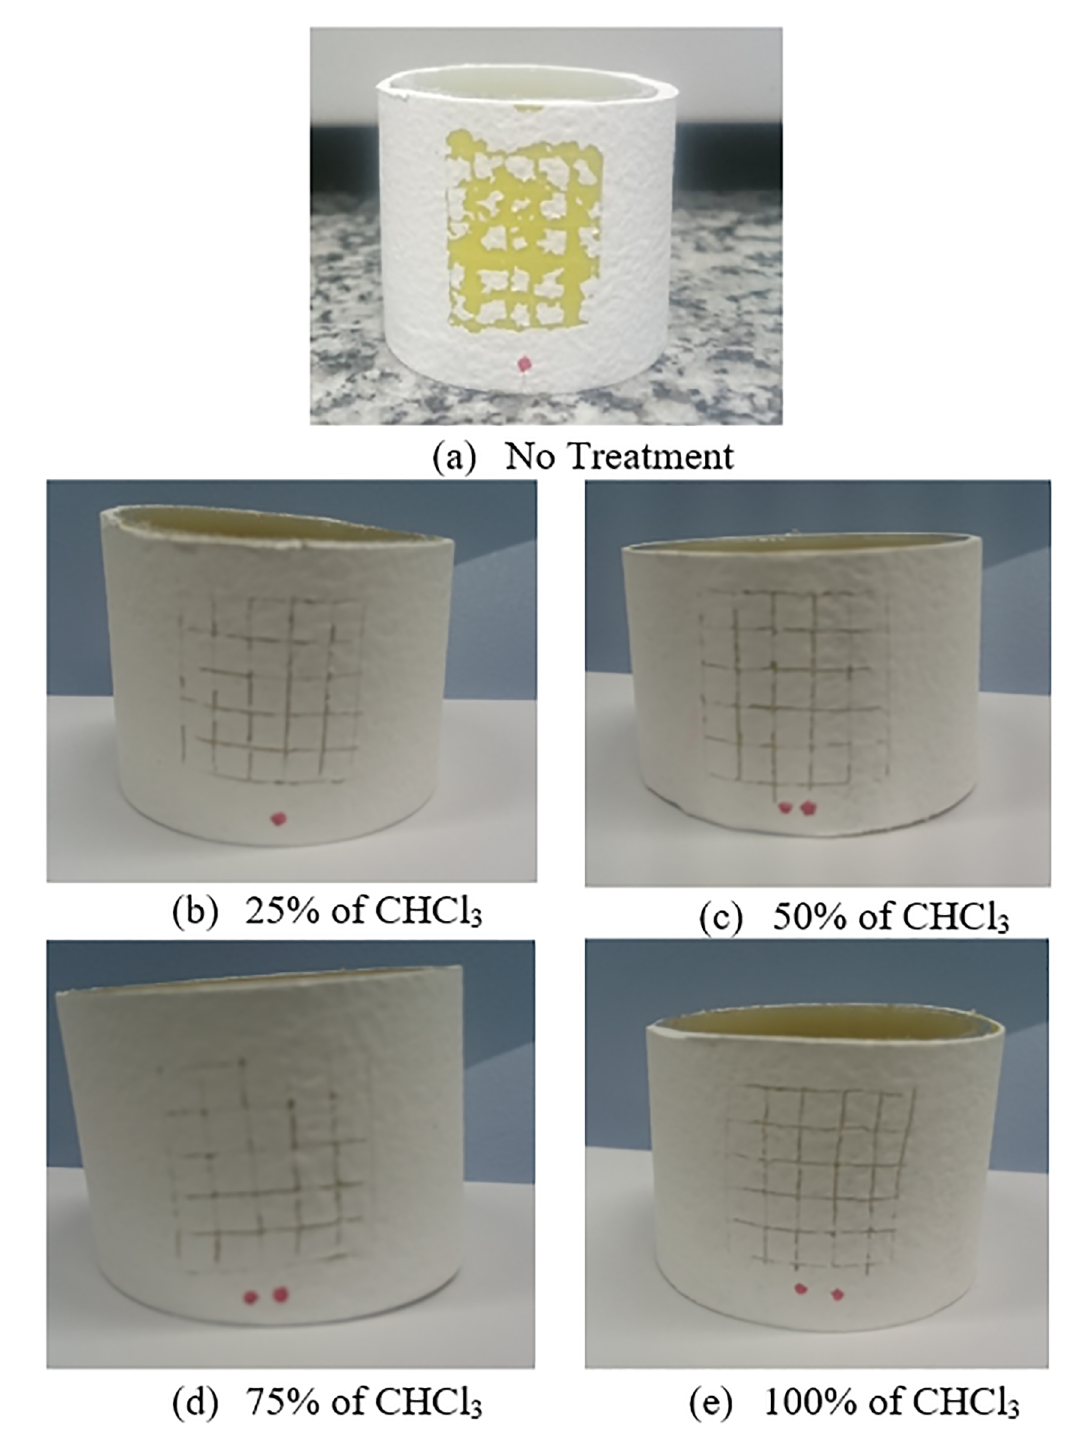
= 0% (untreated); (b) C Cl